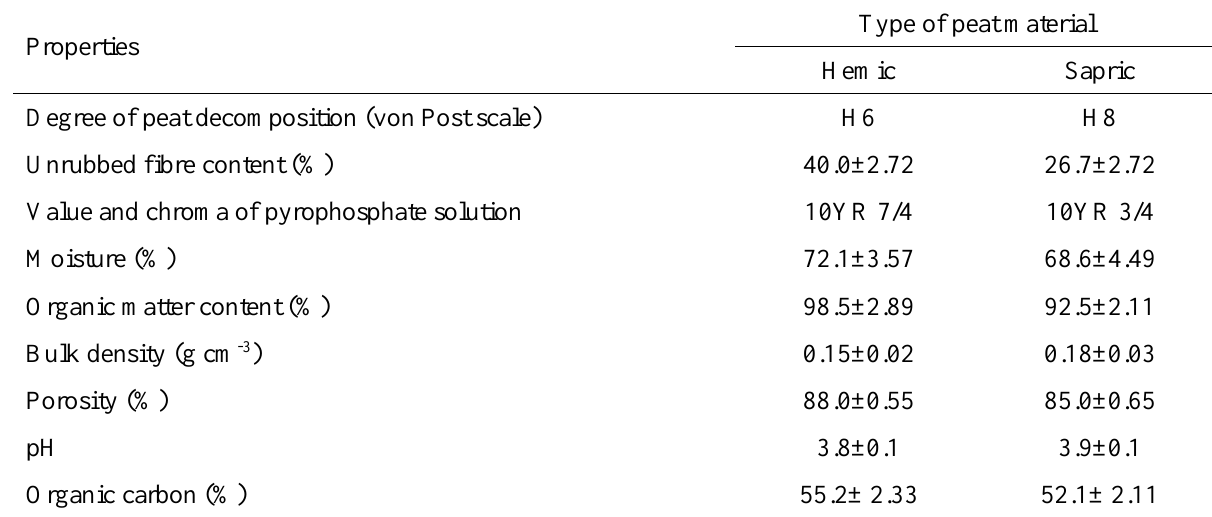
Table 2. Selected physical and chemical properties of the hemic and sapric peat materials prior to planting. The values provided are means of three replicate determinations (n=3). In each case, standard deviation (SD) is shown in parentheses. H6 = well decomposed; H8 = very strongly